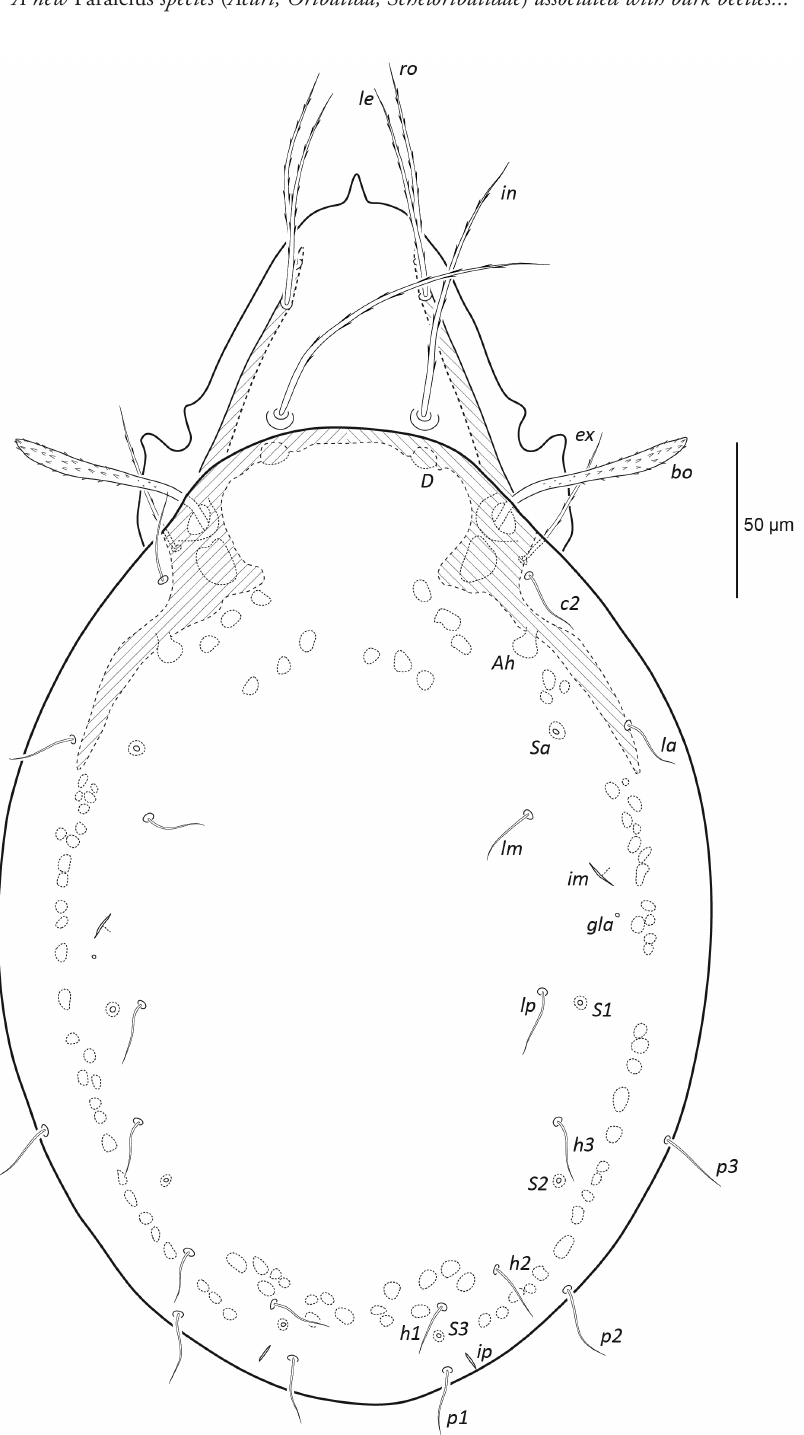
Figure 1. Female Paraleius leahae sp. n. dorsal view, legs